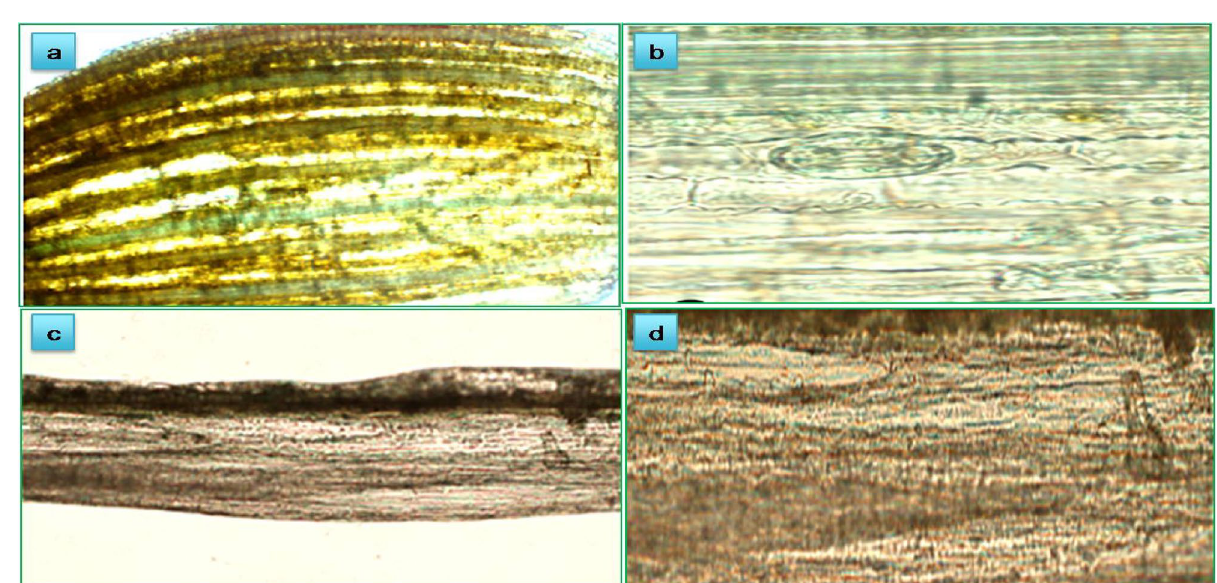
Figure 5. GUS Assay of transgenic sugarcane plants by using fluorescent microscope. ( a , b ) Young transgenic leaf. ( c , d ) Immature transgenic stem